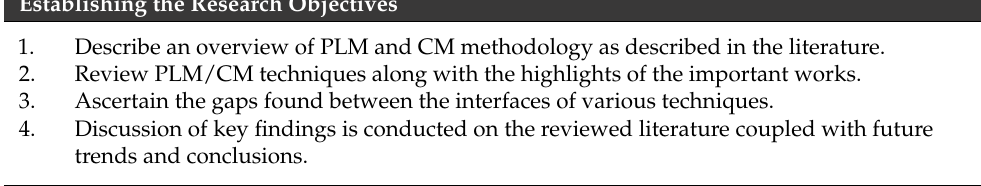
Figure 1. General Change Process Scheme (Adapted from Tavcar and Duhovnik [15]). Table 2. Literature Research Methodology Flow Chart with Inclusion and Exclusion Criteria.